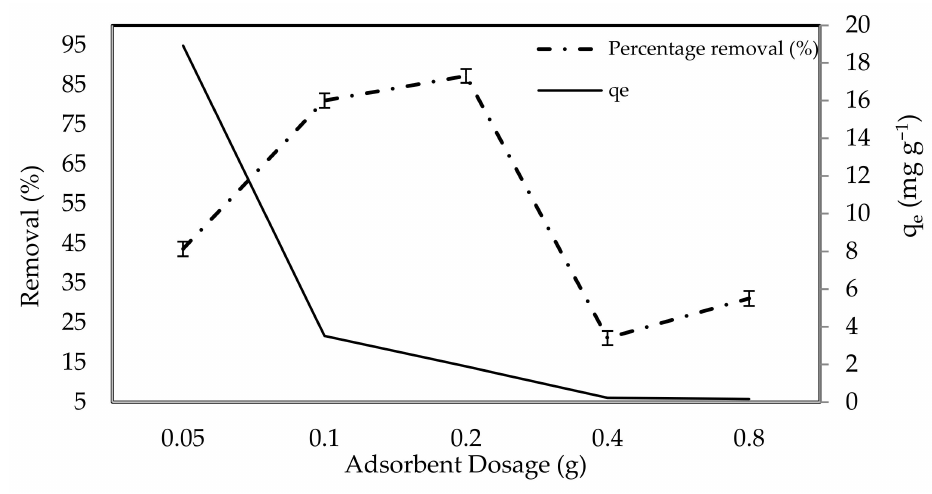
Figure 6. Influence of adsorbent dose on IV2R adsorption.